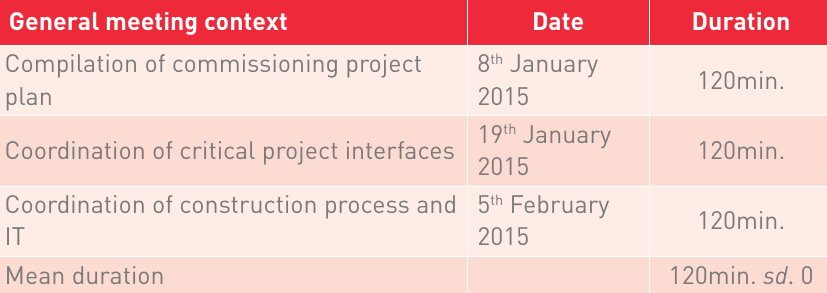
Meetings with observation during the case